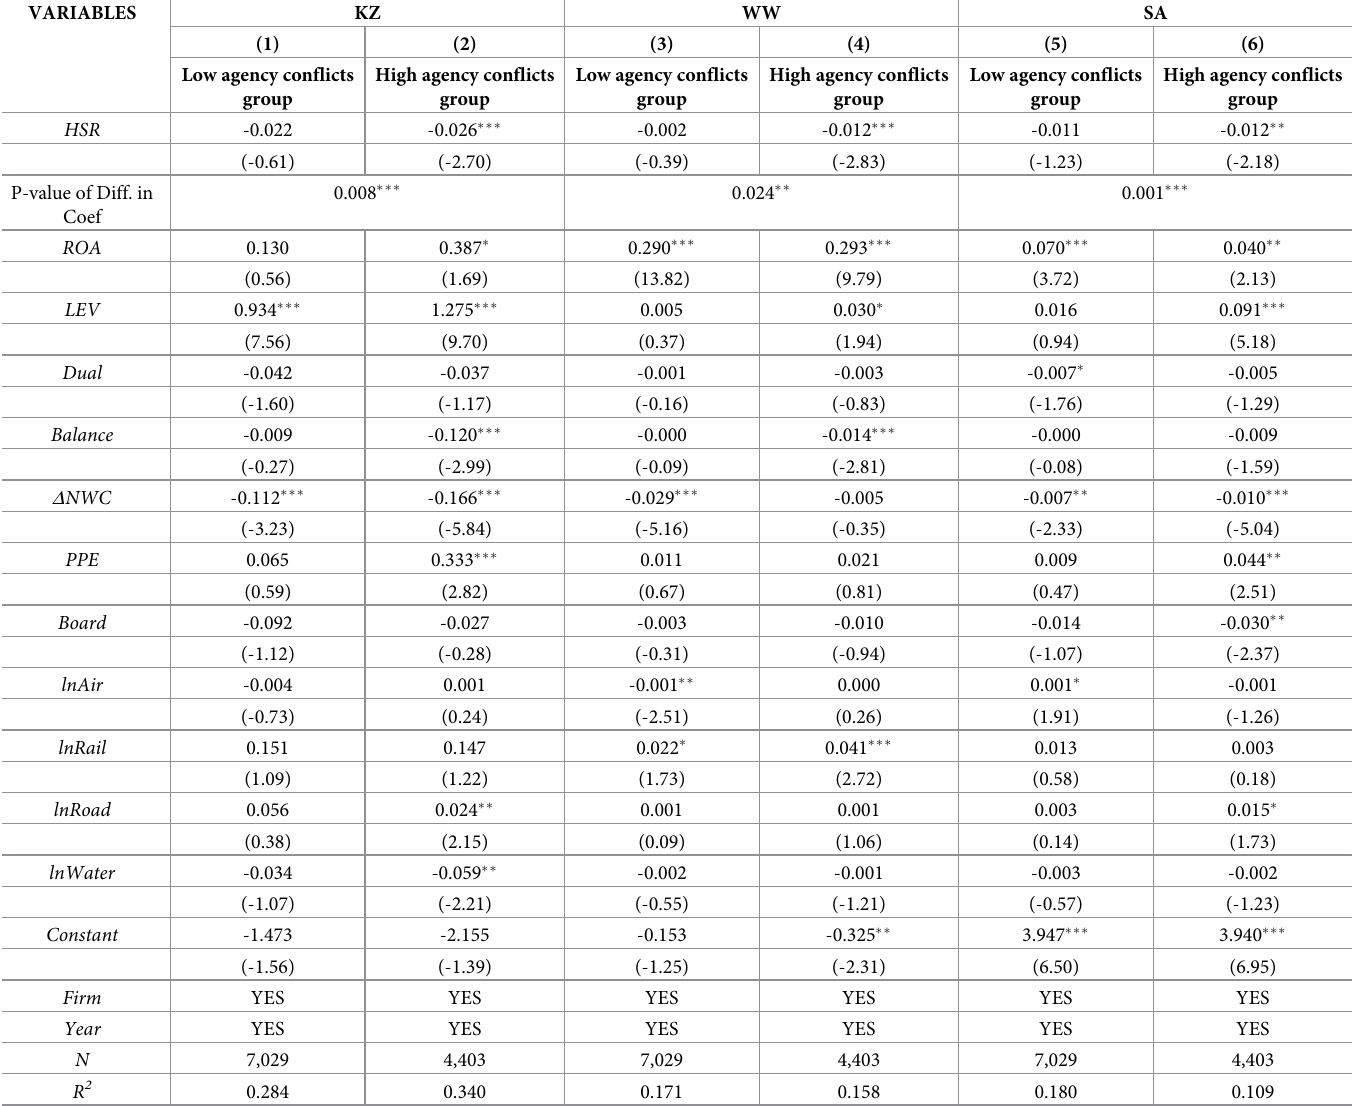
Table 14. The test results of the second type of agency problem mechanism. VARIABLES